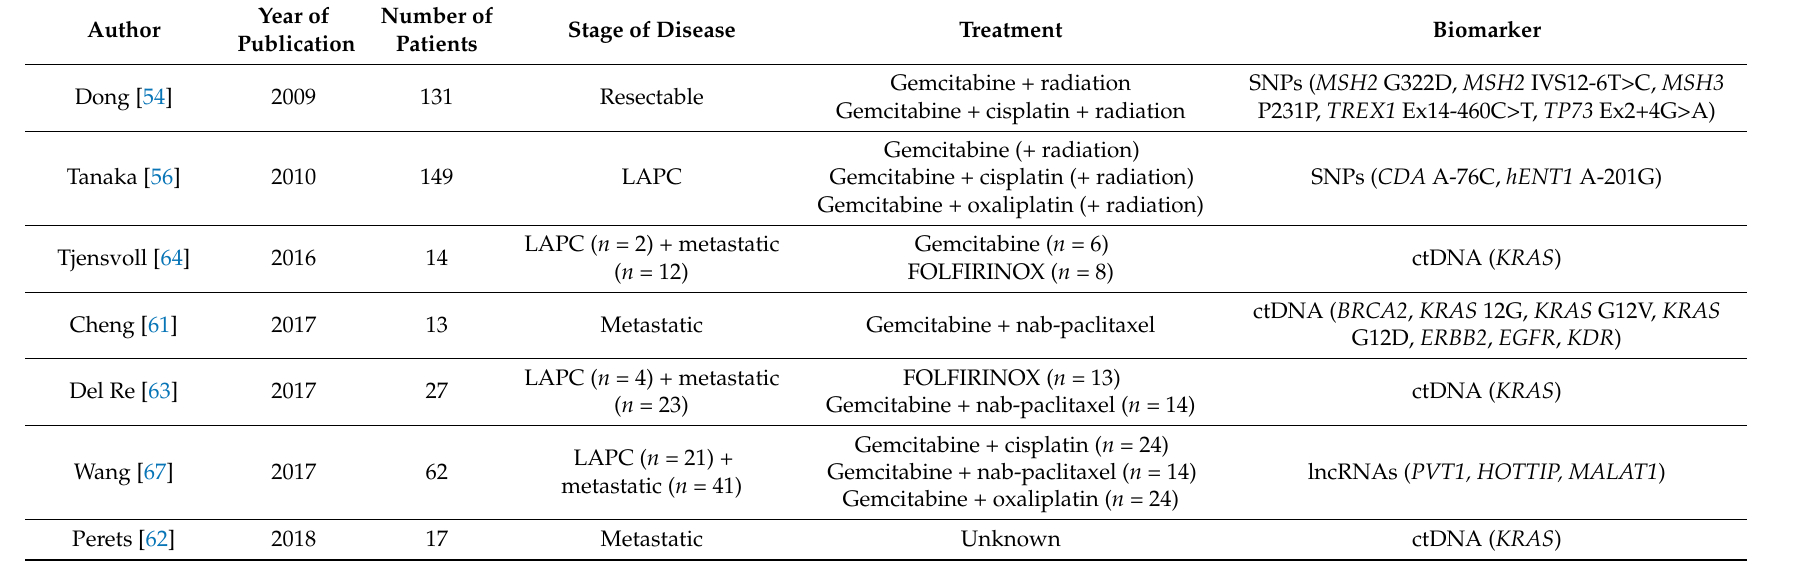
Table 2. Overview of studies including genetic markers as predictive biomarkers for chemotherapy response in pancreatic cancer